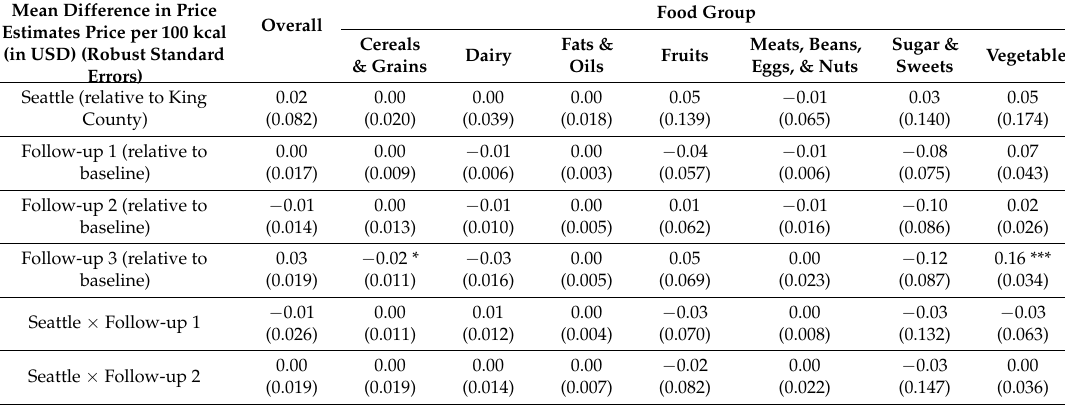
Table 1. Overall and food group stratified linear difference-in-differences model results for the mean change in item-level price per 100 kcal across Seattle (‘intervention’) and King County (‘control’) stores and over time from March 2015 to May 2017, before and during implementation of Seattle’s minimum wage ordinance.